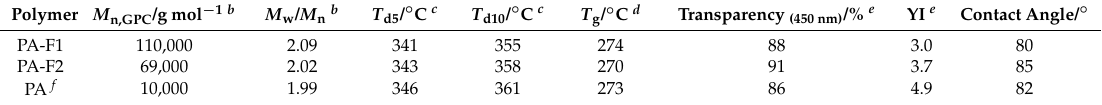
Table 1. Molecular weight, thermal, and optical properties of the obtained PA-F1 and PA-F2 a .